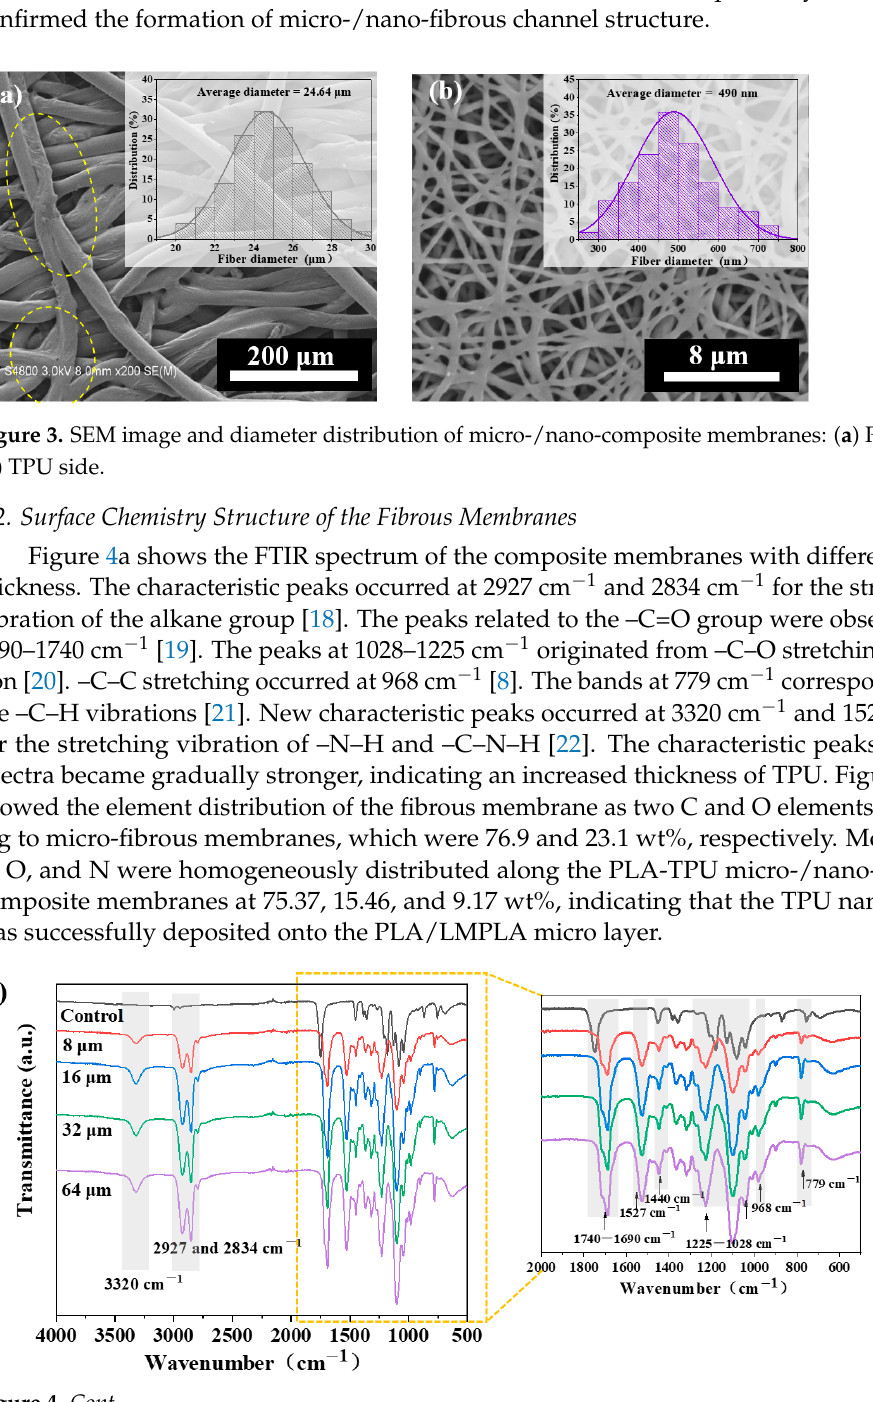
Figure 4. ( a ) FTIR spectrum of the control and composite membranes with various TPU thickness; EDS spectrum of ( b ) the control and ( c ) PLA-TPU-16 composite membranes. 3.3. Wetting Behavior of the Fibrous Membranes The wettability of the micro-/nano-fibrous composite membranes with different TPU thicknesses was evaluated by WCA. Chemical composition and microstructure were key factors in determining wettability [8,23]. The nanolayer on the electrospinning side (re- ferred as “E-side”) presented hydrophobicity, whereas the un-electrosprayed side (re- ferred as “U-side”) maintained its hydrophilic property. Figure 5 shows that the hydro- phobic performance of the TPU side was associated with the layer thickness. When the water was dropped onto the control membranes, the different sides of the membranes showed excellent hydrophilicity due to their hydrophilic property. For the PLA-TPU-8 composite membranes, the U side exhibited a similar hydrophilic property. Significantly, the WCA of the nano-fibrous side (E side) were 121°, 120.5°, 96°, 42°, and 0° at 1 s, 5 s, 7 s, 9 s, and 10 s. Furthermore, when the nano-fibrous layer thickness was in the range be- tween 16 and 64 μ m, the WCA of the E side was 120° within 10 s because of the increasing of the accumulating density. Notably, it is clearly found that water droplets on the U side were quickly spread out within 1 s. The results indicate that the composite membranes provide asymmetrical wetting performance and the TPU nano-layer thickness played a beneficial role in building the Janus structure.